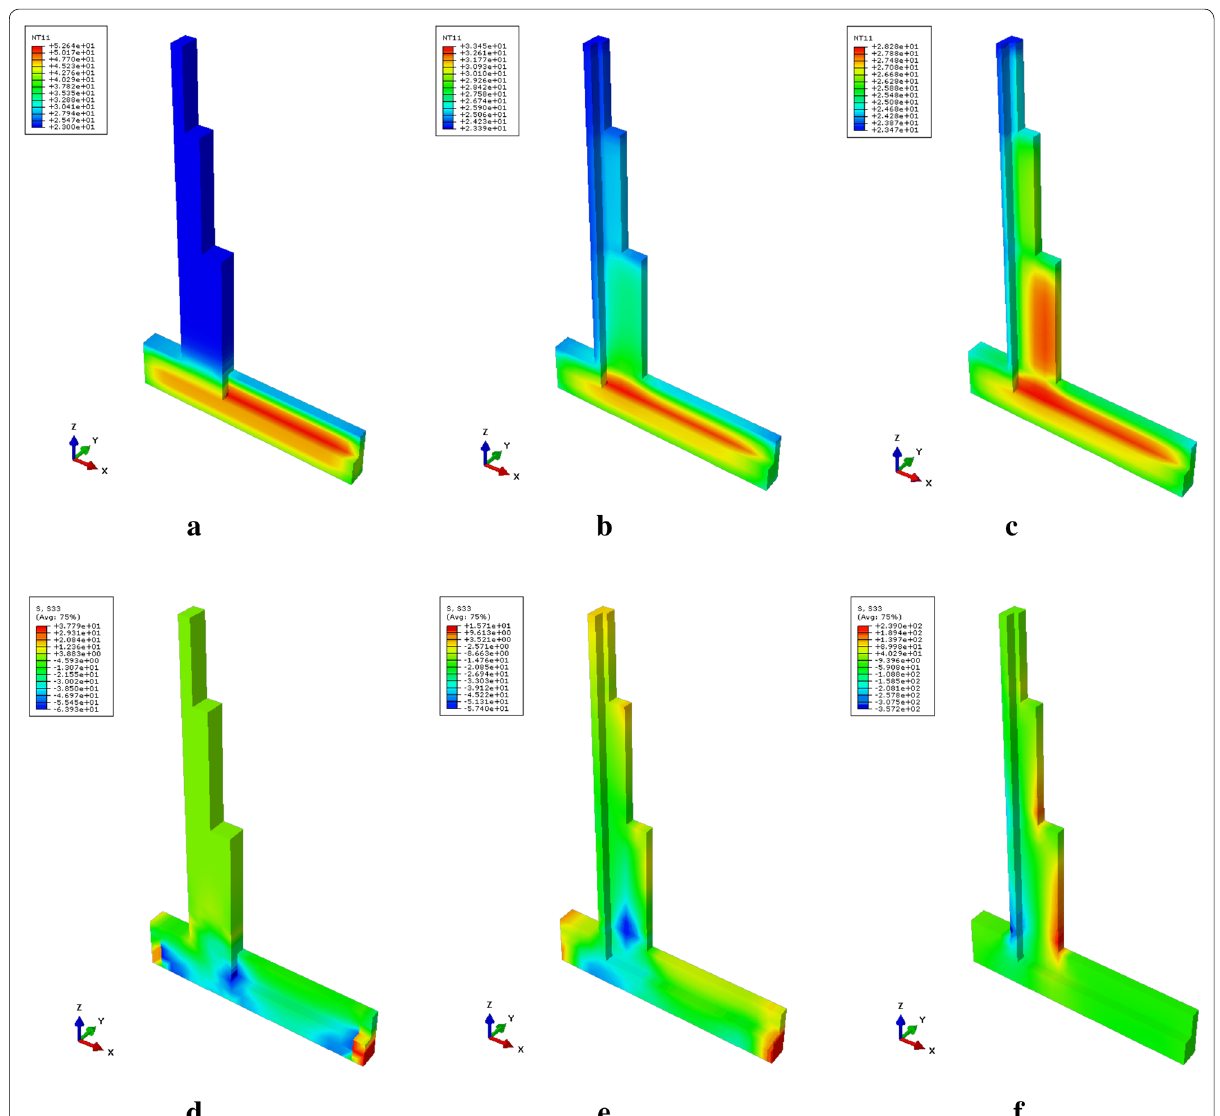
Fig. 18 Thermo‑mechanical response of the retaining wall: Temperature distribution (in °C) at a 3 days; b 11 days; and c 28 days; and vertical stresses (in N/cm 2 ) at d 3 days; e 11 days; and f 28